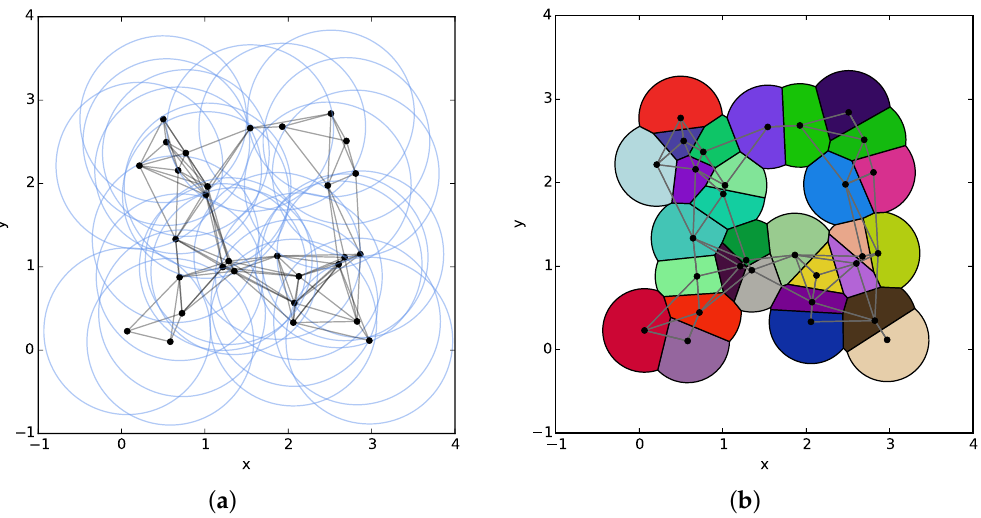
Figure 7. The r -disk graph and corresponding r /2-limited Voronoi diagram of a WSN. ( a ) The r -disk graph. ( b ) The r /2-limited Voronoi diagram. Table 3. The computational time of the individual Exact Voronoi Tessellation (EVT) and BS algorithms and those embedded in the framework of the Adjust-Sensing-Radius (ASR)